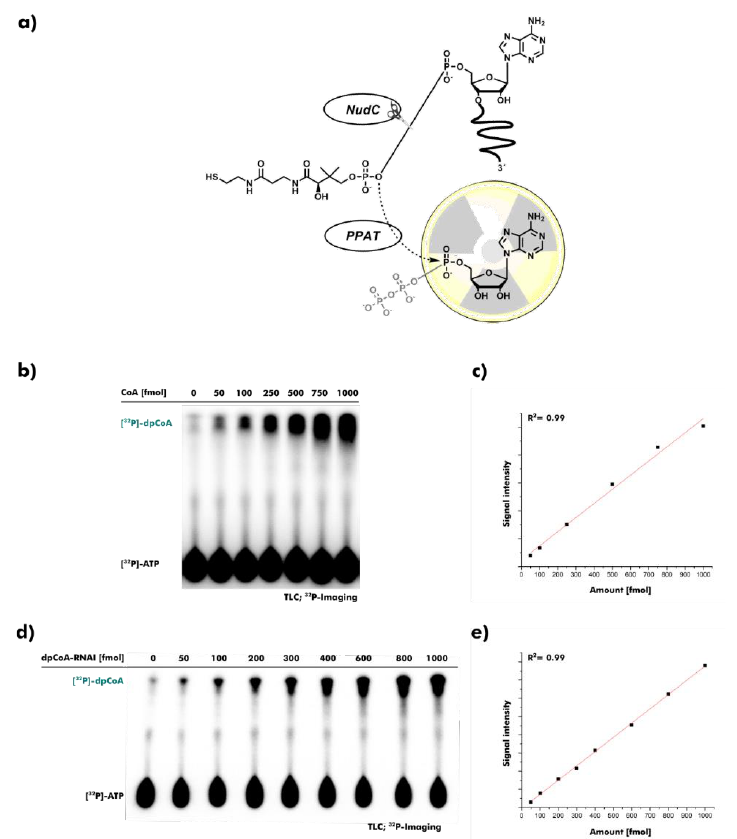
Figure 2. Assay development for the quantification of CoA and dpCoA-RNA. ( a ) Schematic overview of the assay principle. CoA or dpCoA-RNA is hydrolyzed to uniform phosphopantetheine (PPant) by E. coli nudix hydrolase NudC. PPant is subsequently converted to [ α - 32 P]-dpCoA by E. coli phosphopantetheine adenylyltransferase (PPAT) in the presence of [ α - 32 P]-ATP. ( b ) The [ α - 32 P]- dpCoA signal for 50–1000 fmol CoA is separated using thin-layer chromatography (TLC) and visualized using 32 P-imaging. ( c ) The linear correlation between the amount of CoA and [ α - 32 P]- dpCoA signal is depicted. ( d ) The [ α - 32 P]-dpCoA signal for 50–1000 fmol dpCoA-RNA is separated using TLC and visualized using 32 P-imaging. ( e ) The linear correlation between the amount of dpCoA-RNA and [ α - 32 P]-dpCoA signal is